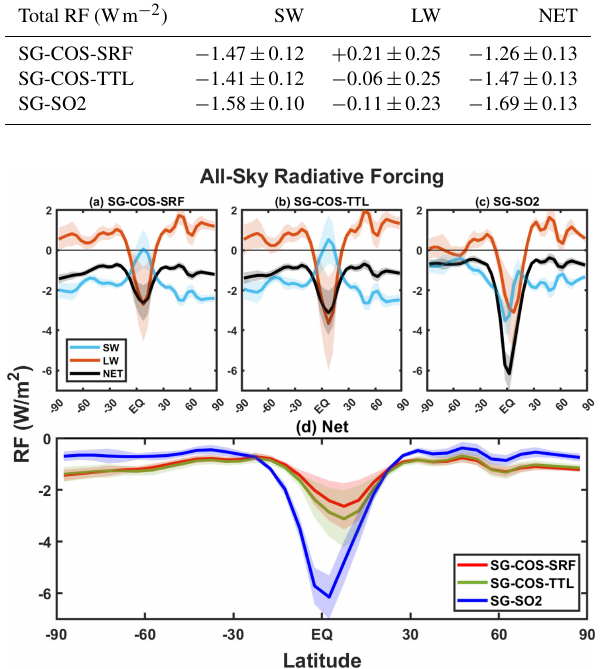
Figure 9. (a–c) Mean zonal shortwave (cyan), longwave (orange), and net (black) all-sky radiative forcing (in Wm − 2 ) in SG-COS- SRF, SG-COS-TTL, and SG-SO2, respectively. (d) Comparison of the net radiative forcings from SG-COS-SRF (red), SG-COS-TTL (green), and SG-SO2 (blue). All quantities are annually averaged over the years 2046–2055. Shadings in all panels represent 1 stan- dard deviation in the interannual